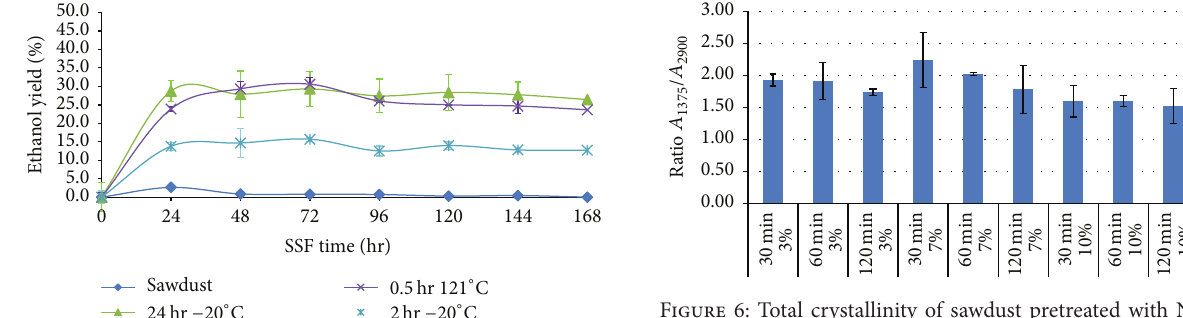
Figure 6: Total crystallinity of sawdust pretreated with NaOH at 60 ∘